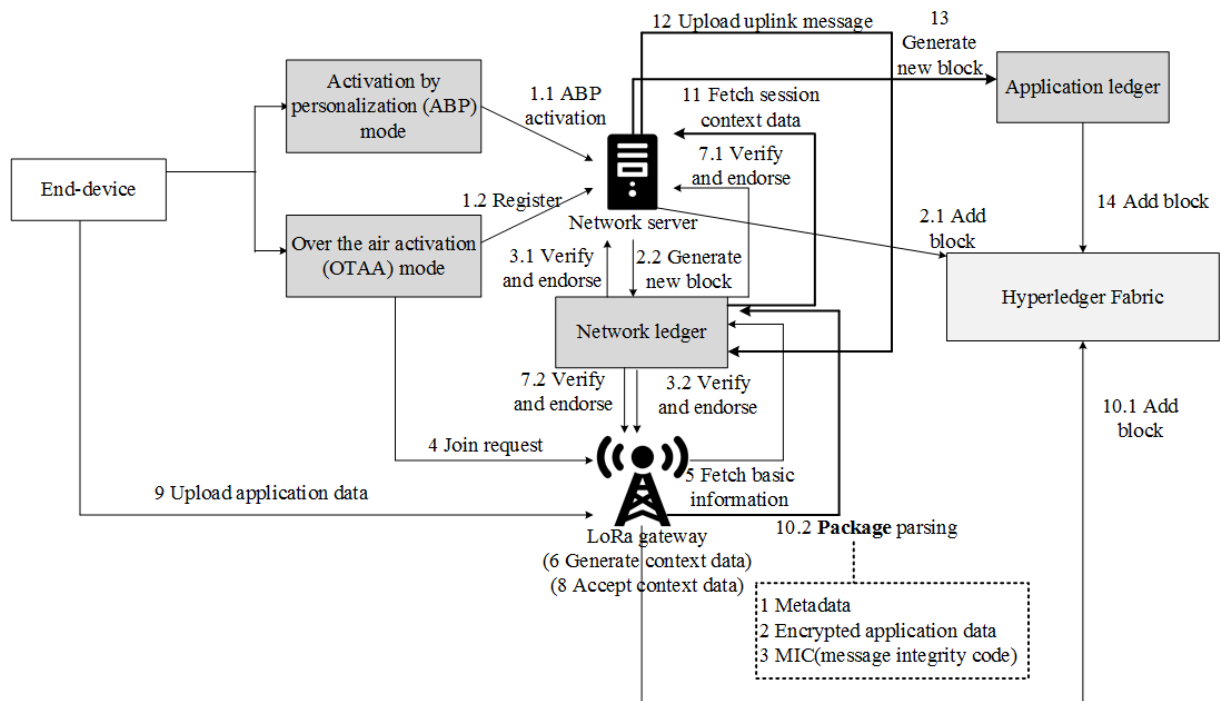
Figure 18. Reconstruction diagram of reference [41].